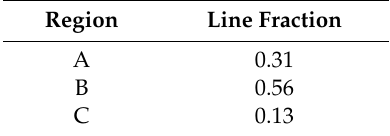
Table 12. Line fractions of Regions A, B and C at loaded edge.